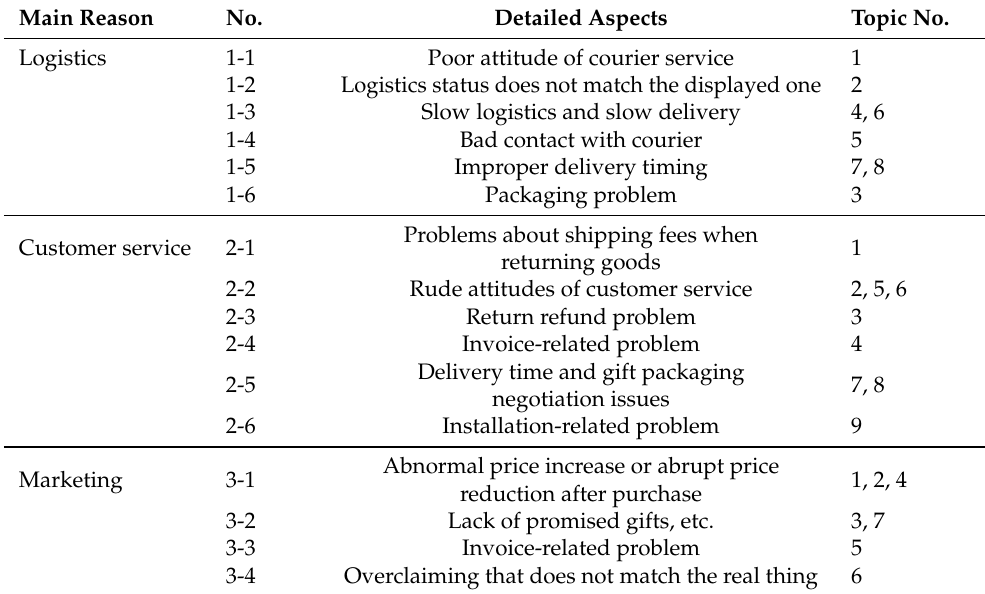
Table 2. Detailed aspects for complaints about logistics, customer service and